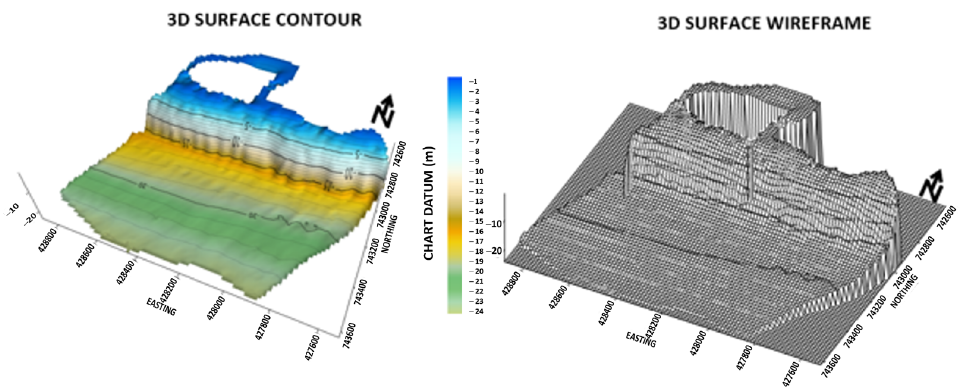
Figure 5. Bathymetry Survey at Mantanani Island.